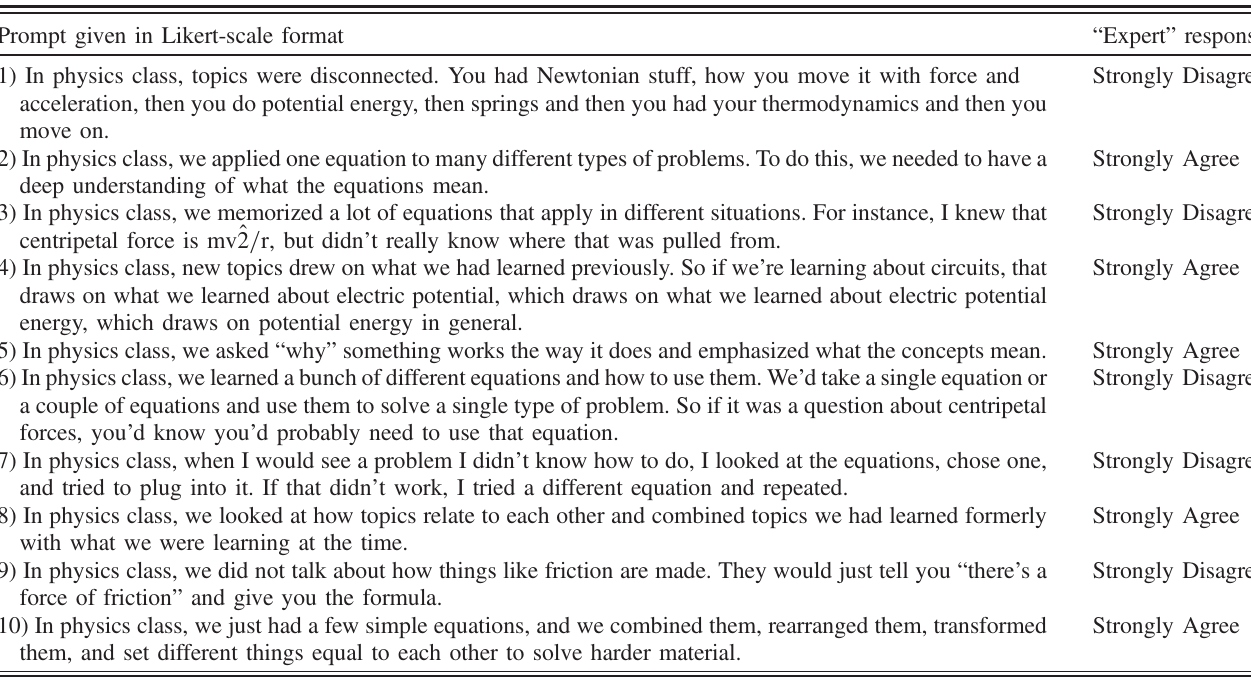
TABLE II. The Perceptions Survey. Students who selected the “ expert ” response were scored as indicating that their physics course strongly encouraged expertlike